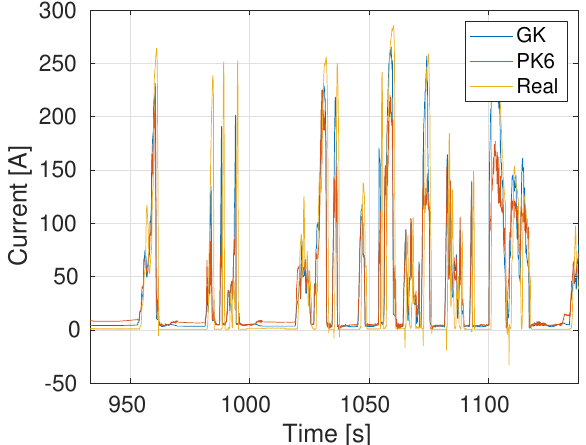
Figure 6. Current prediction: Training using a 15’ sample of Route 1 and Testing on a small portion of Route 3.